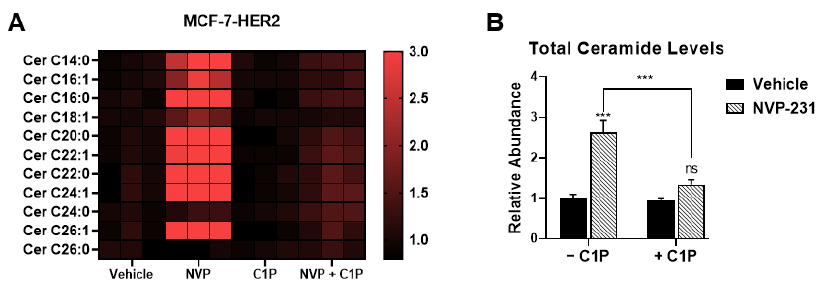
Figure 6. C1P addback partially reverses NVP-mediated ceramide increases. ( A ) MCF-7-HER2 cells were treated with 1 µ M NVP-231, 1 µ M C8-C1P, or a combination of NVP-231 and C8-C1P for 48-h. Abundance of all ceramide species relative to the vehicle-treated control was determined by LC-MS and is presented as a heatmap. ( B ) Total ceramide levels were calculated by dividing the abundance of all ceramide species by the average abundance of all ceramides in vehicle-treated controls and are presented as fold changes compared to vehicle-treated control in a bar plot. ns: not significant, *** p < 0.001.